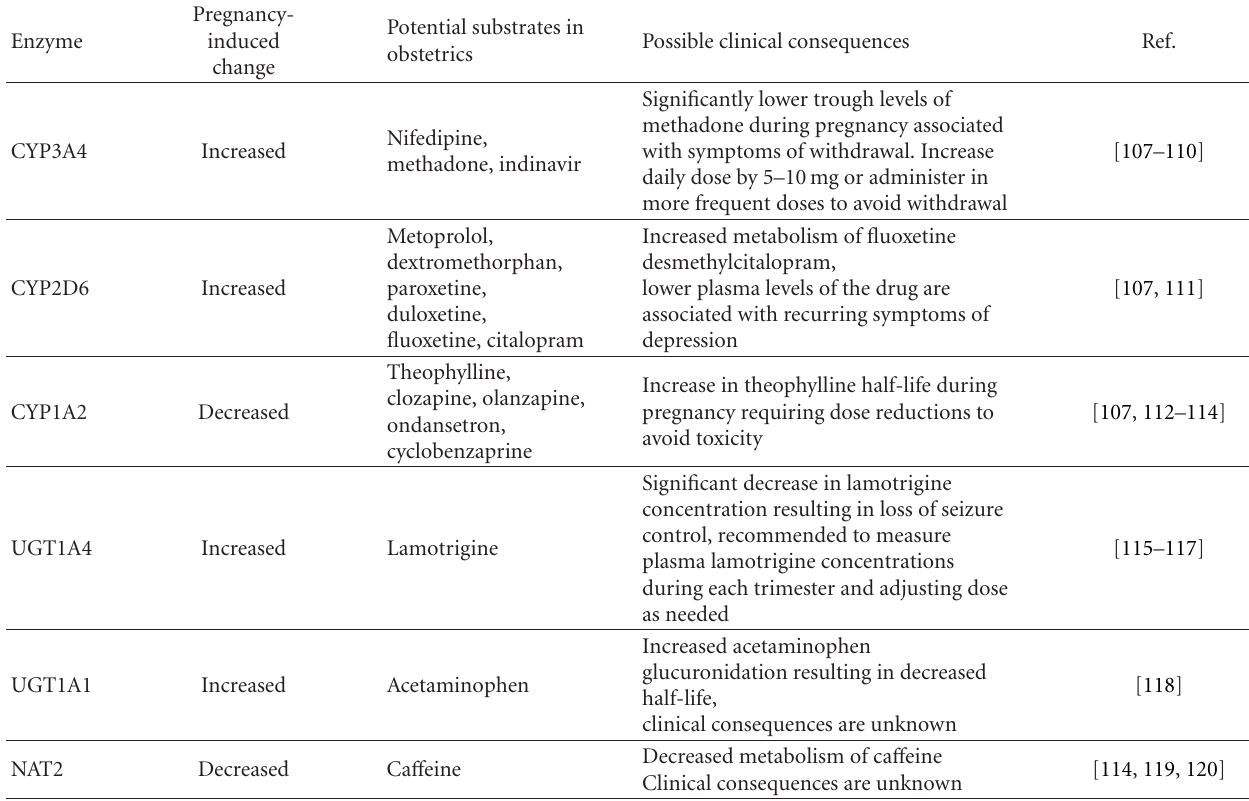
Table 4: Pregnancy-induced enzyme-specific